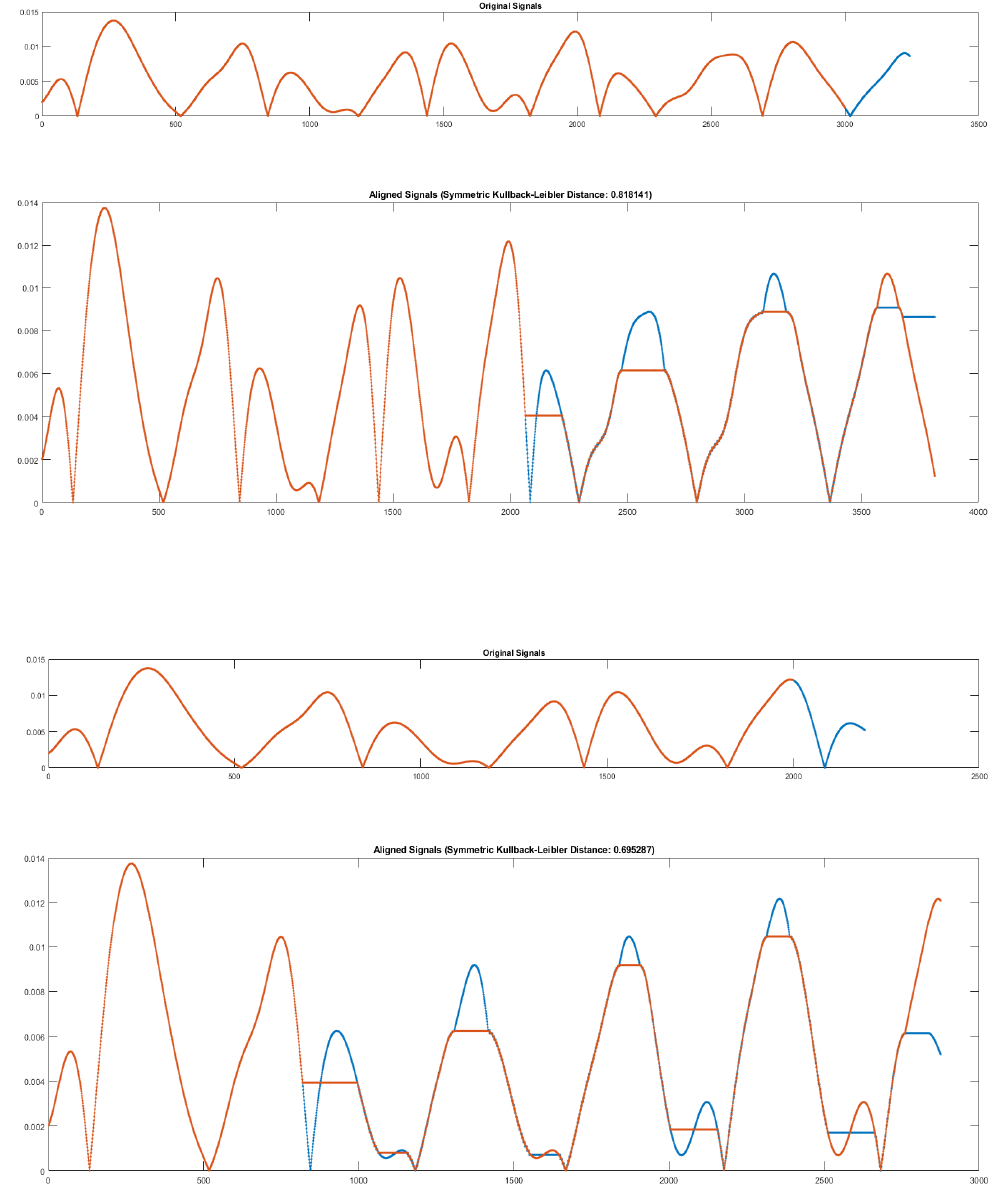
Figure 8. Diagrams of two computation of similarity distance δ k xy ( k ) through SKL distance.